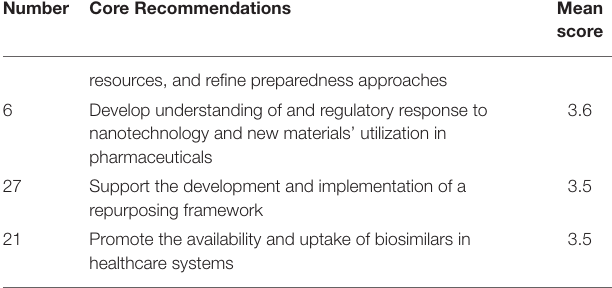
TABLE 3 | Overall comparison of all Core Recommendations by mean score (question